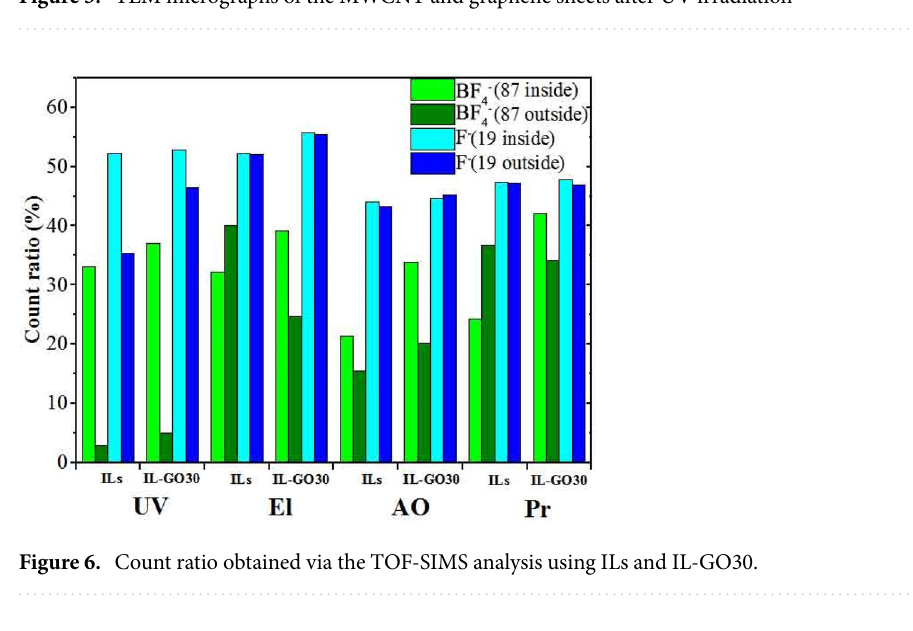
Figure 5. TEM micrographs of the MWCNT and graphene sheets after UV irradiation